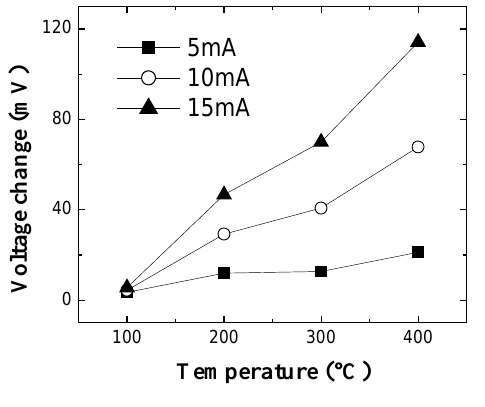
Figure 6. Change in MOS diode forward voltage at fixed currents as a function of temperature for measurement in 100%N